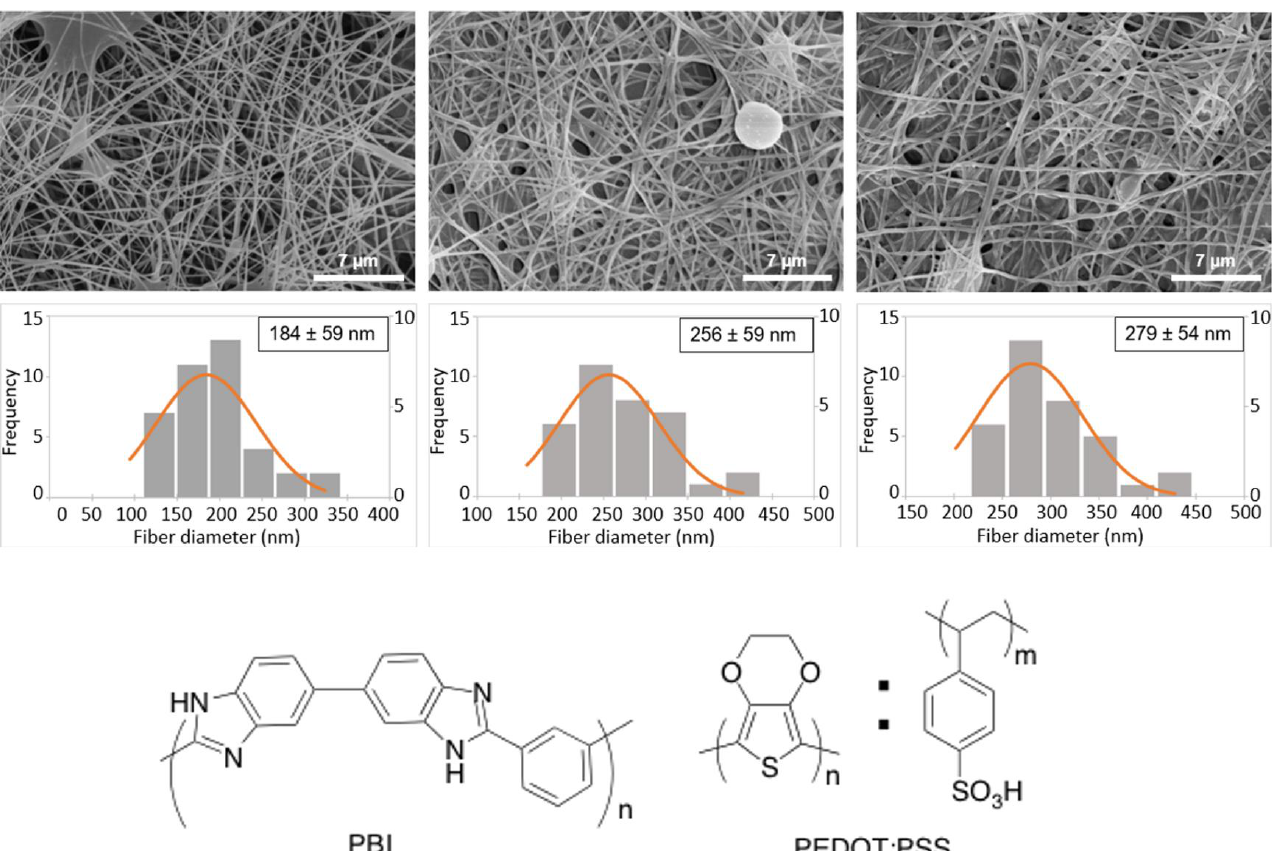
Figure 1. SEM images ( top ) and respective fiber diameter distributions ( middle ) of pristine electrospun PBI, cross-linked PEDOT:PSS-spin coated PBI and cross-linked PEDOT:PSS-dip coated PBI nanofibers. Scale bar: 7 μm. The discreet histogram values are represented on the left yy -axis and the normal probability density function each mean and standard deviation are represented on the right yy -axis. Chemical structures of poly [ 2,2′-m-(phenylene)-5,5′-bibenzimidazole] (PBI) and poly (3,4-ethylenedioxythiophene) doped with poly (styrene sulfonic acid) (PEDOT:PSS) are shown in the ( bottom )